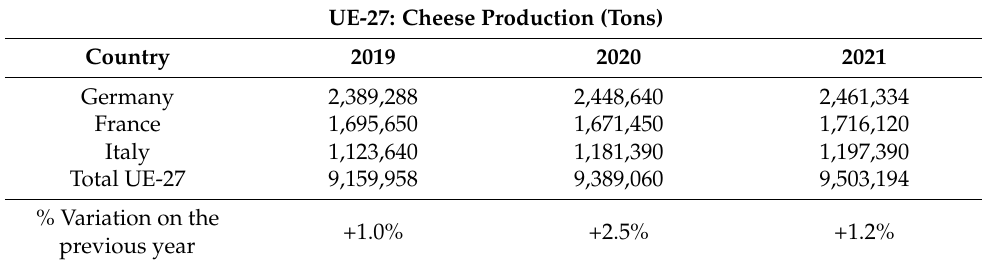
Table 2. The main European cheese-producing nations.